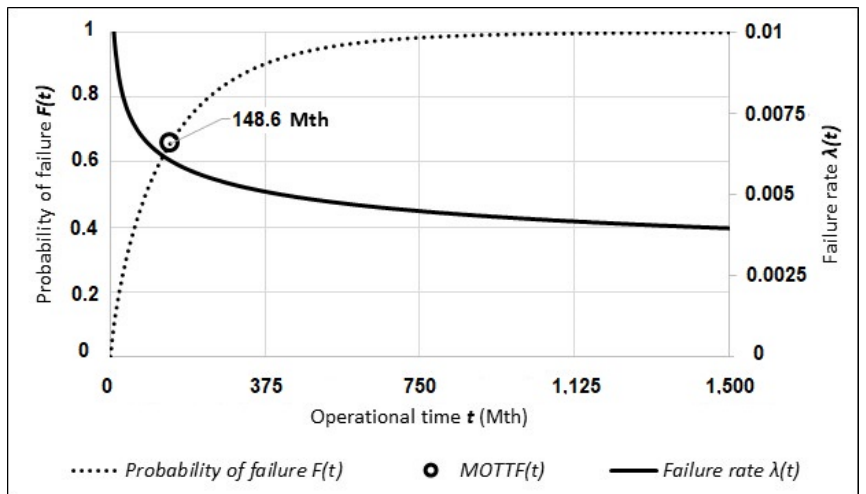
Figure 5 Failure rate λ (t) for the forwarder f810D-001. Figure 5. Failure rate λ (t) for the forwarder